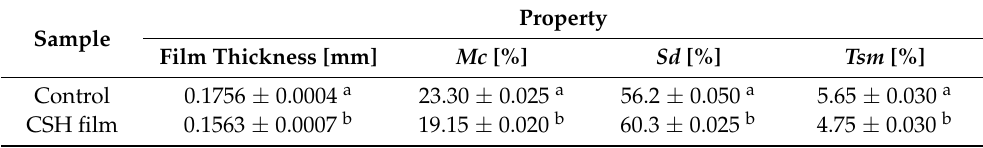
Table 1. The hygroscopic properties of the CSH film samples compared with the control samples. Property Sample Film Thickness [mm] Mc [%] Sd [%] Tsm [%] Control 0.1756 ± 0.0004 a CSH